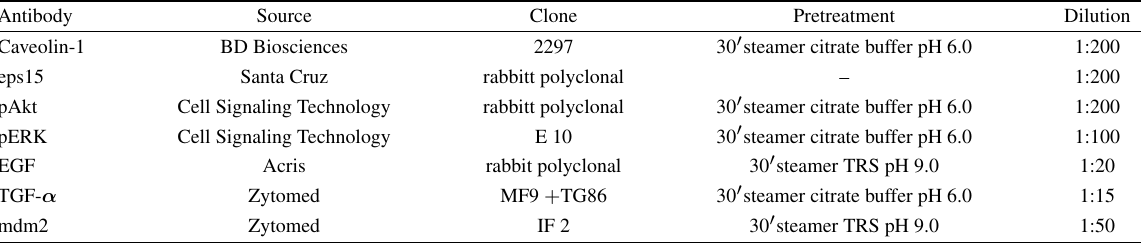
Overview of all antibodies used in this study, including source, pretreatment, dilution and detection systems Antibody Source Clone Pretreatment Caveolin-1 Cell Signaling